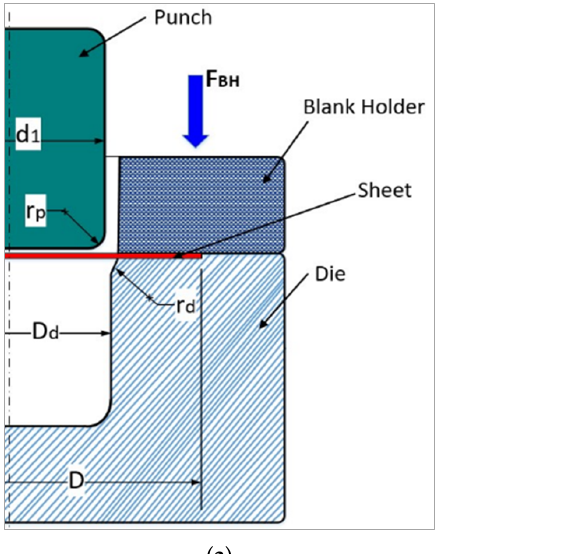
Figure 4. Determining the forming limit stress diagram (FLSD) by yield theory [30].